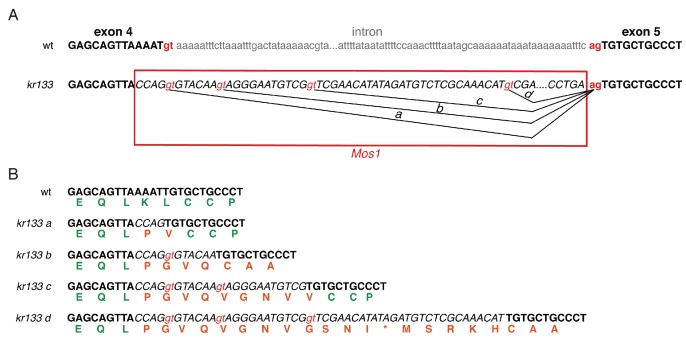
- Characterization of the kr133 mutant allele.(A) Wild-type crld-1 and crld-1(kr133) genomic loci. Only a part of the exon 4 and exon 5 sequence is shown (bold). Regions of the intron sequence (in grey) and of the Mos1 sequence (red box) have been omitted (annotated as ‘…”). The Mos1 insertion in kr133 is located in the fourth exon of crld-1. Cryptic splice donor sites (in red) present within the Mos1 sequence are used at low frequency to generate in-frame messenger RNAs (a, b, c and d indicated by black lines). (B) Alternative crld-1 mRNAs detected by RT-PCR in crld-1(kr133) alleles (a, b, c, and d) and conceptual protein translations. The single-letter amino acid code is under the second nucleotide of the corresponding codon. Wild-type protein sequence is in green and mutated residues introduced by alternative splicing of the Mos1 transposon are in orange.